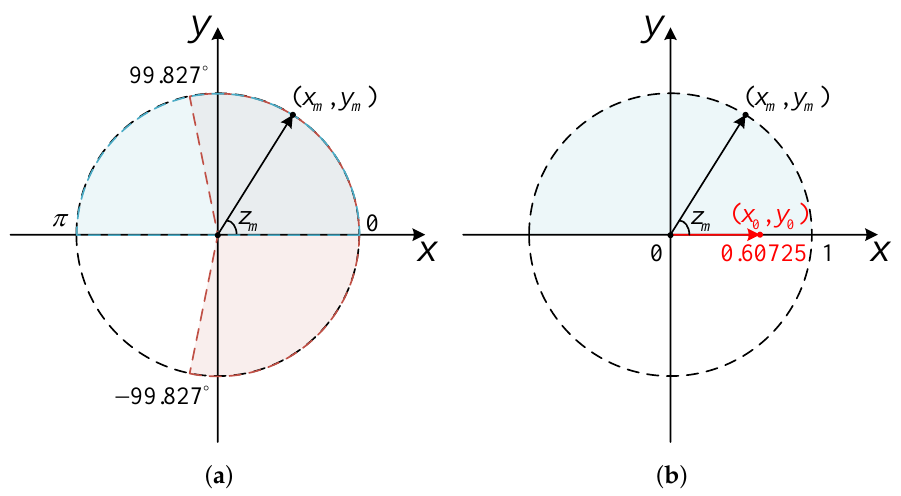
Figure 5. The improvement of the CORDIC algorithm: ( a ) quadrant transform; ( b ) parameter modification.